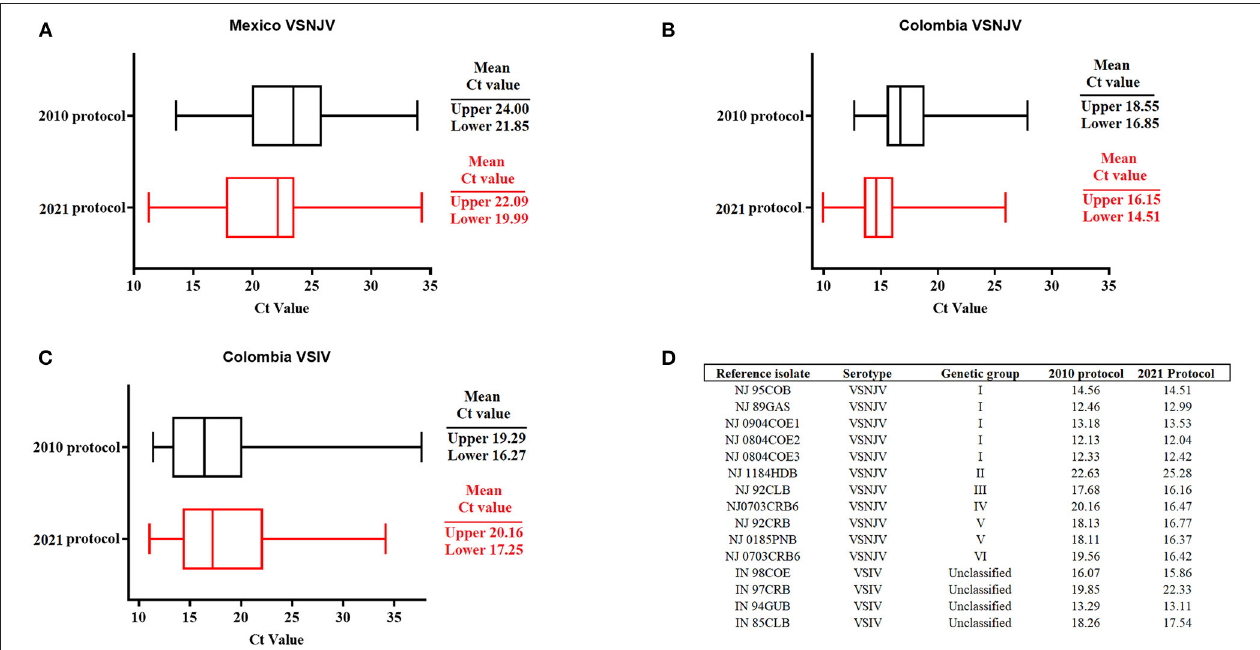
FIGURE 4 | Validation of the 2021 protocol for detection of VSV. Validation was performed using a set of VSNJV field samples from (A) Mexico, (B) Colombia, and VSIV field samples from (C) Colombia. (D) Isolates representing the different genetic groups of VSNJV and VSIV. Comparisons were established using historical values obtained during the validation of the 2010 protocol. Upper and lower means of Cts were calculated using JMP PRO software with the standard error set at p <